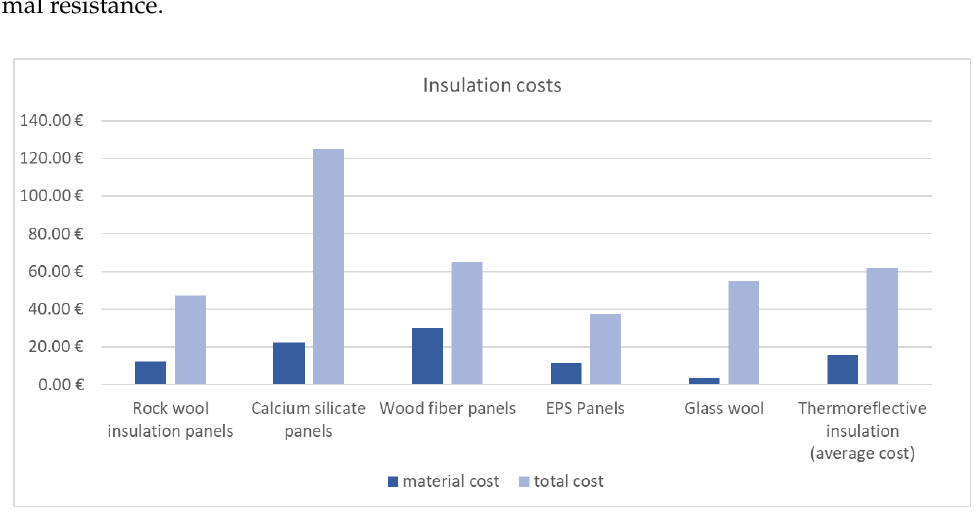
Figure 11. Total cost for insulation with different materials of the heat-reflective materials with the correspondent thermal resistance. Approximation of the results with a second-degree polynomial